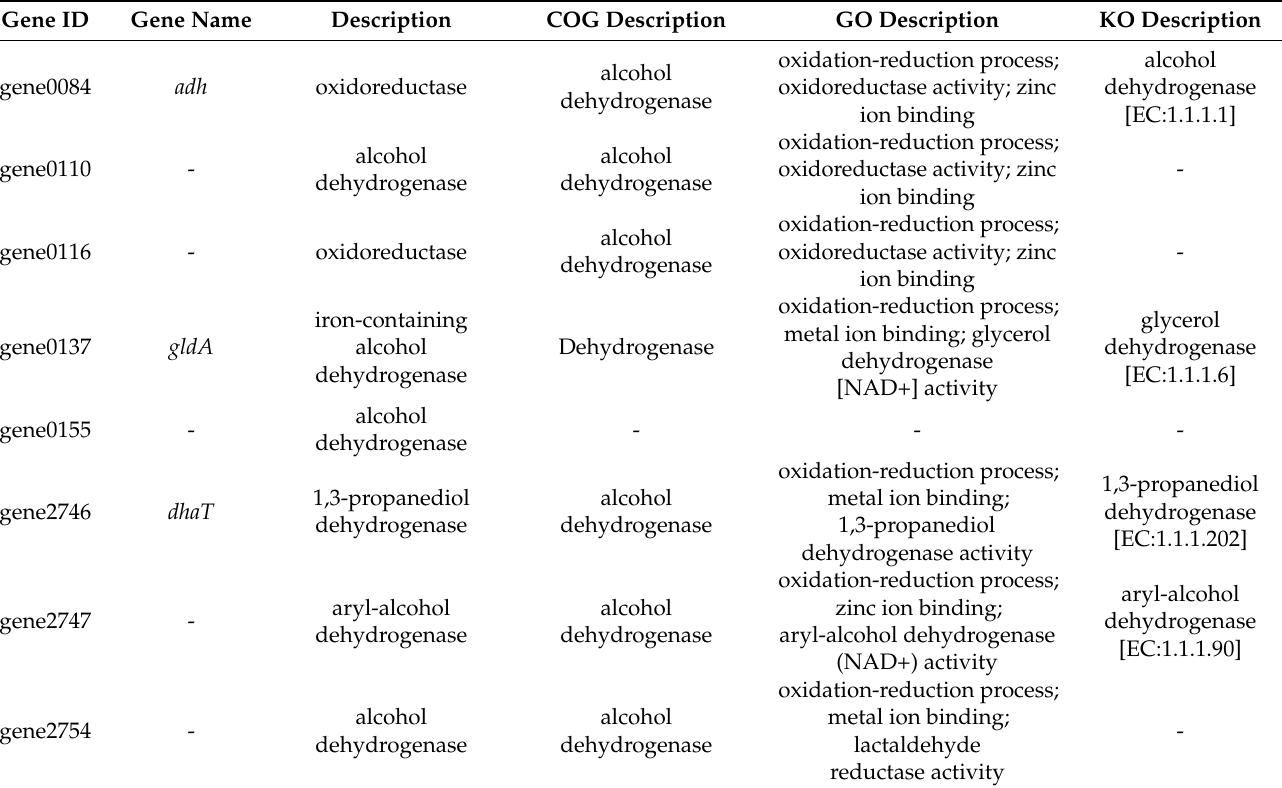
Table 3. Selected genes associated with alcohol